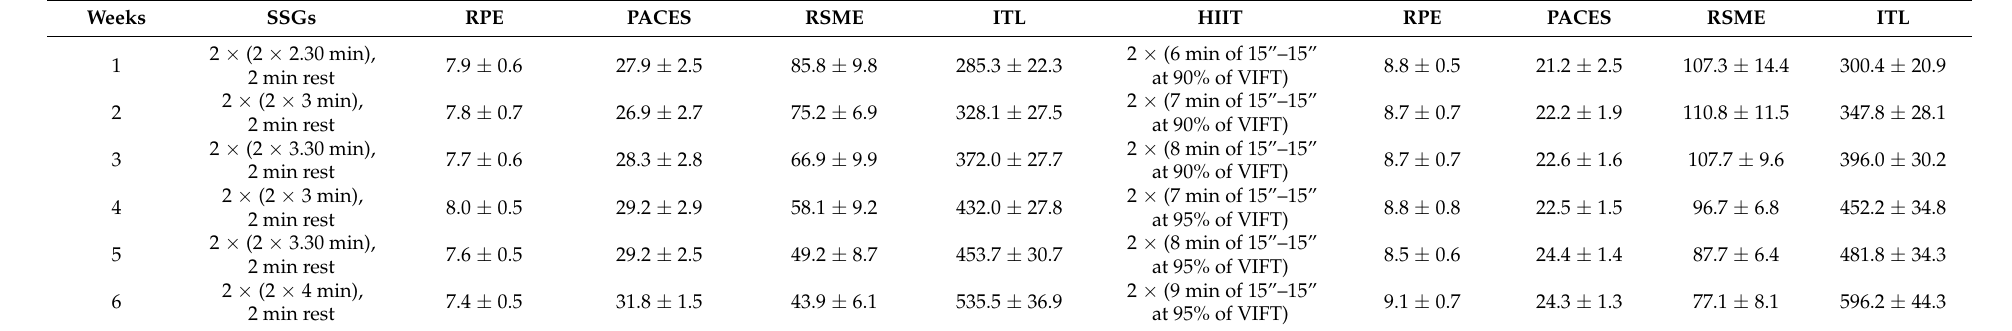
Table 1. Description of the 6 weeks of SSGs and HIIT training programs, the weekly psychophysiological responses, and internal training load.